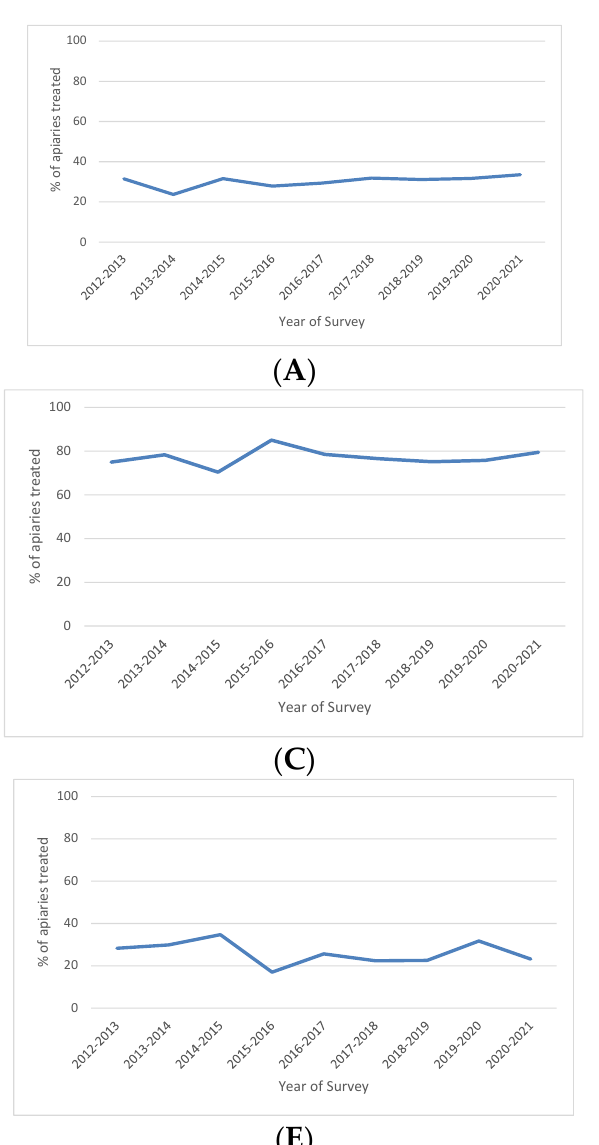
Figure 2. ( A ) Percentages of apiaries undergoing treatments based on drone brood removal. ( B ) Percentages of apiaries undergoing treatments using other biotechnical methods (e.g., trapping comb, complete brood removal, queen confinement). ( C ) Percentages of apiaries undergoing treatments with oxalic acid trickling. ( D ) Percentages of apiaries undergoing treatments with oxalic acid sublimation (evaporation). ( E ) Percentages of apiaries undergoing treatments with thymol (e.g., Apiguard,